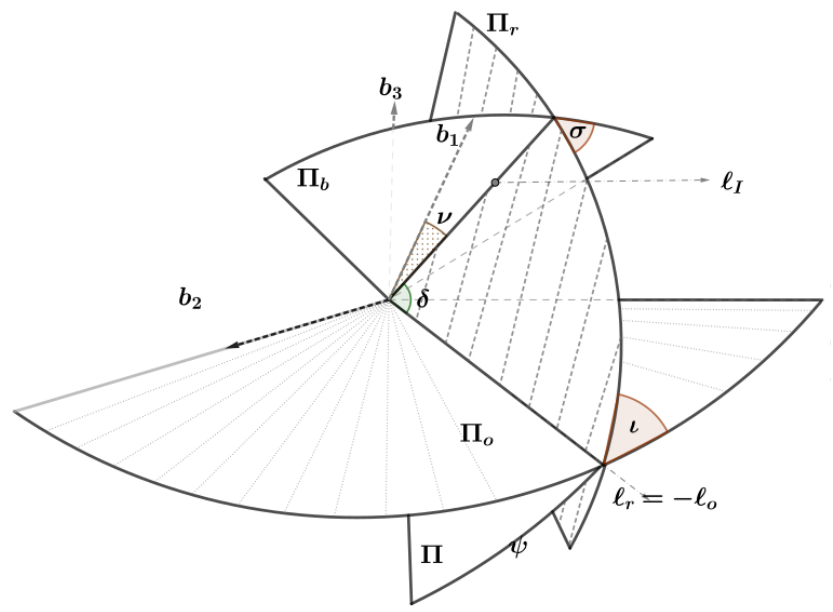
Fig. 10 Special relative equilibria of the body-inclined